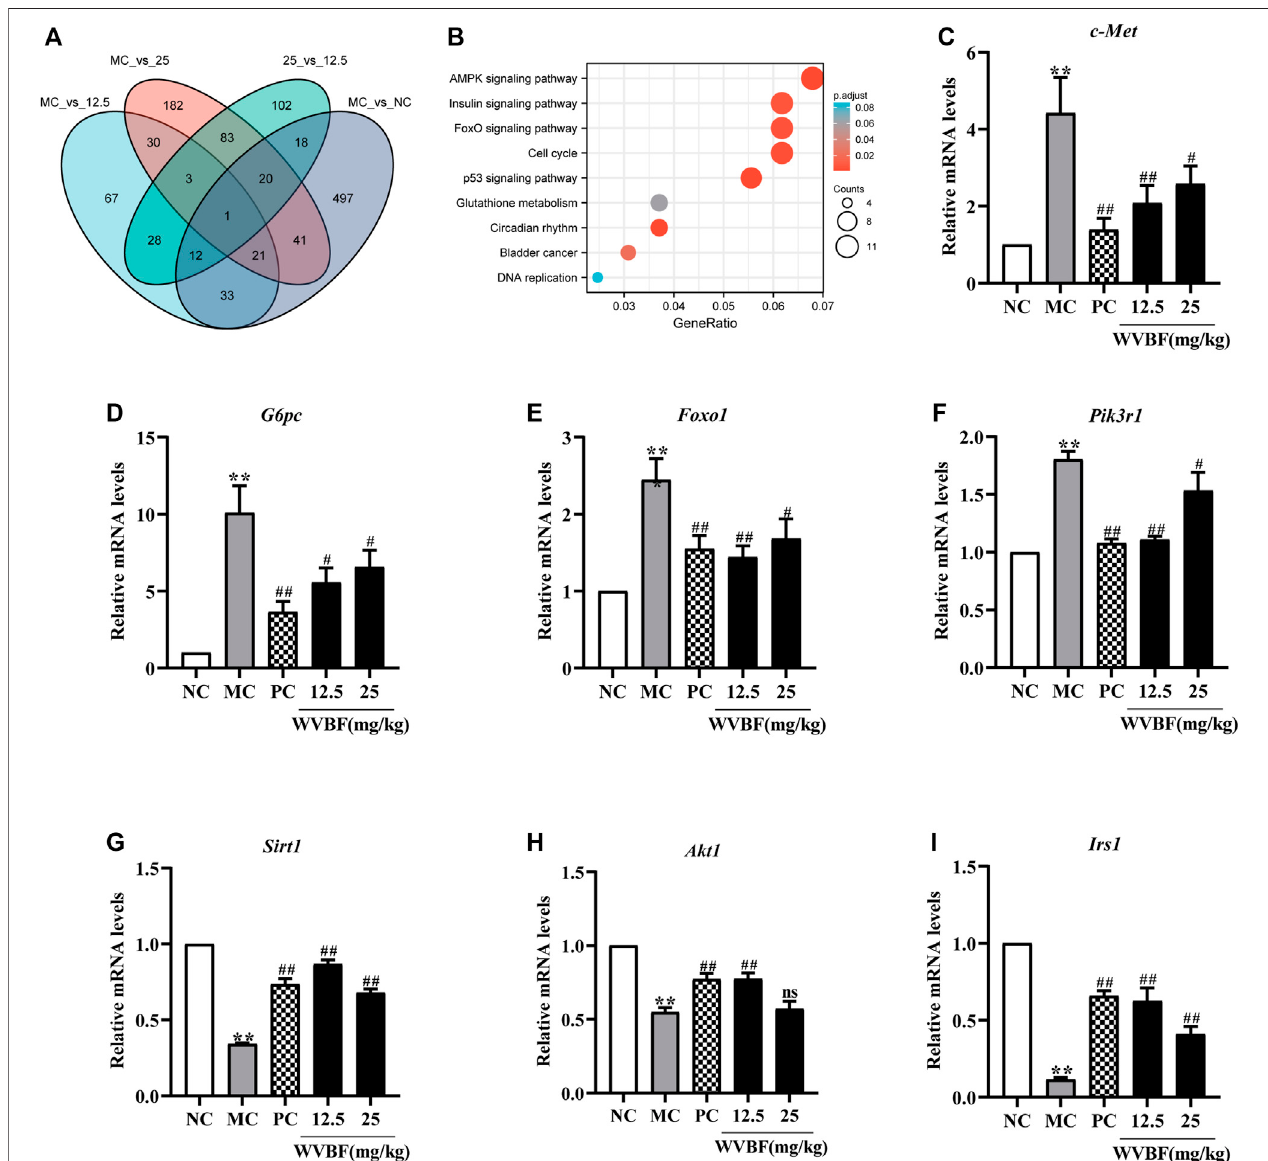
FIGURE 3 | Screening and veri fi cation of differentially expressed genes in diabetic rats. (A) Venn diagram of differentially expressed genes (DEGs) in the different groups. (B) Enrichment analysis of Kyoto Encyclopedia of Genes and Genomes (KEGG) annotation signaling pathway (WVBF 25 mg/kg-treated versus MC). (C – I) The key gene (c-Met, G6pc, Foxo1, pik3r1, Sirt1, Akt1, Irs1) expression in liver tissues from different groups. NC: normal control, MC: mellitus control, PC: positive control, 12.5:WVBF12.5 mg/kg/day,25:25 mg/kg/day.Datewereshownasmean ± SEM;* p < 0.05,** p < 0.01 vs .NCgroup;# p < 0.05,## p < 0.01, vs .MCgroup. n (cid:1) 3 in each